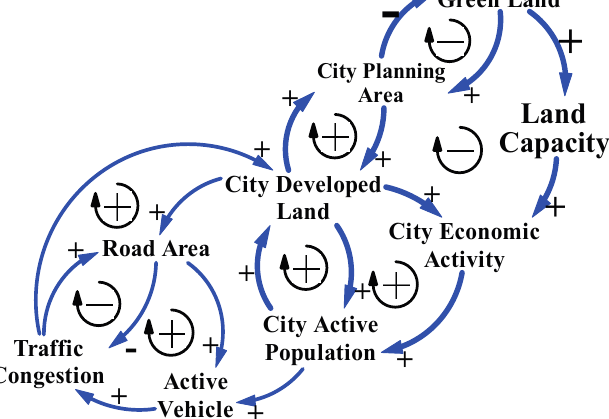
Figure 10. The causality of positive and negative feedback loops in the CLD model indicate